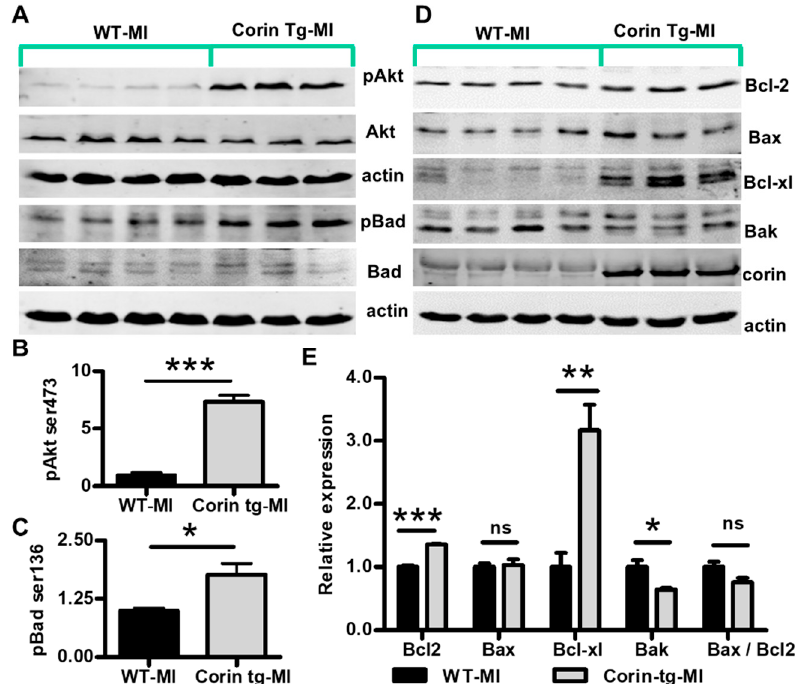
Figure 4. Cardiac corin overexpression modulates activity and expression level of pro-apoptotic and anti-apoptotic proteins in the infarcted heart. ( A ) Expression and phosphorylation of Akt (Ser473) and Bad (Ser136) were assessed by Western-blotting under reduced conditions in post-MI tissues from corin-Tg and WT hearts. Actin was used as loading control. ( B , C ) Densitometry analysis of the pAkt (60 kD) and pBad (23 kD) normalized to Akt (60 kD) and Bad (25 kD), respectively. ( D ) Expression of Bcl-2 family proteins, Bcl2, Bax, Bcl-xl, and Bak in corin-Tg and WT hearts post-MI. Cardiac corin (206 kD) overexpression was also confirmed. ( E ) Densitometry analysis of Bcl2 (26 kD), Bax (23 kD), Bcl-xl (30 kD), and Bak (30 kD) expression normalized to actin (43 kD) and, of the Bax / Bcl2 ratio. Heart group. * p < 0.05, ** p < 0.01, *** p < 0.001 and ns, not significant.